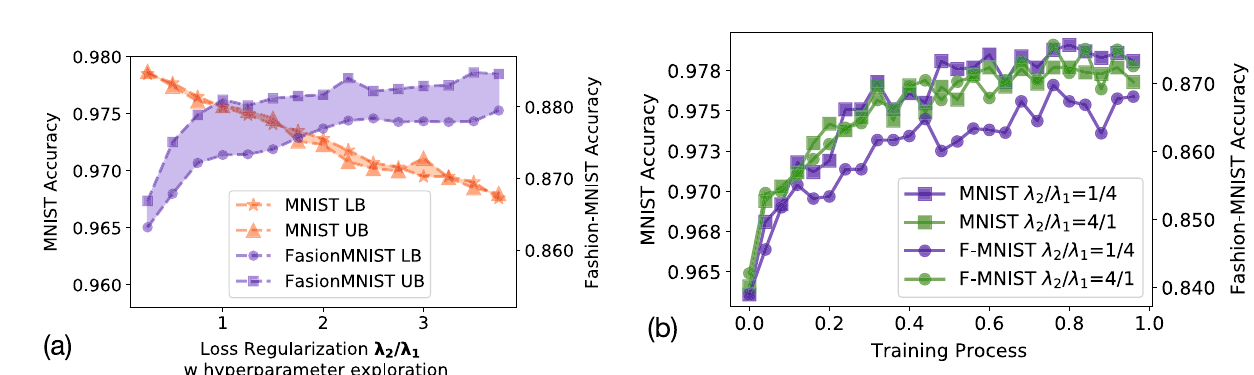
0, 0.2 . ( b ) Prediction performance ∈ [ ]